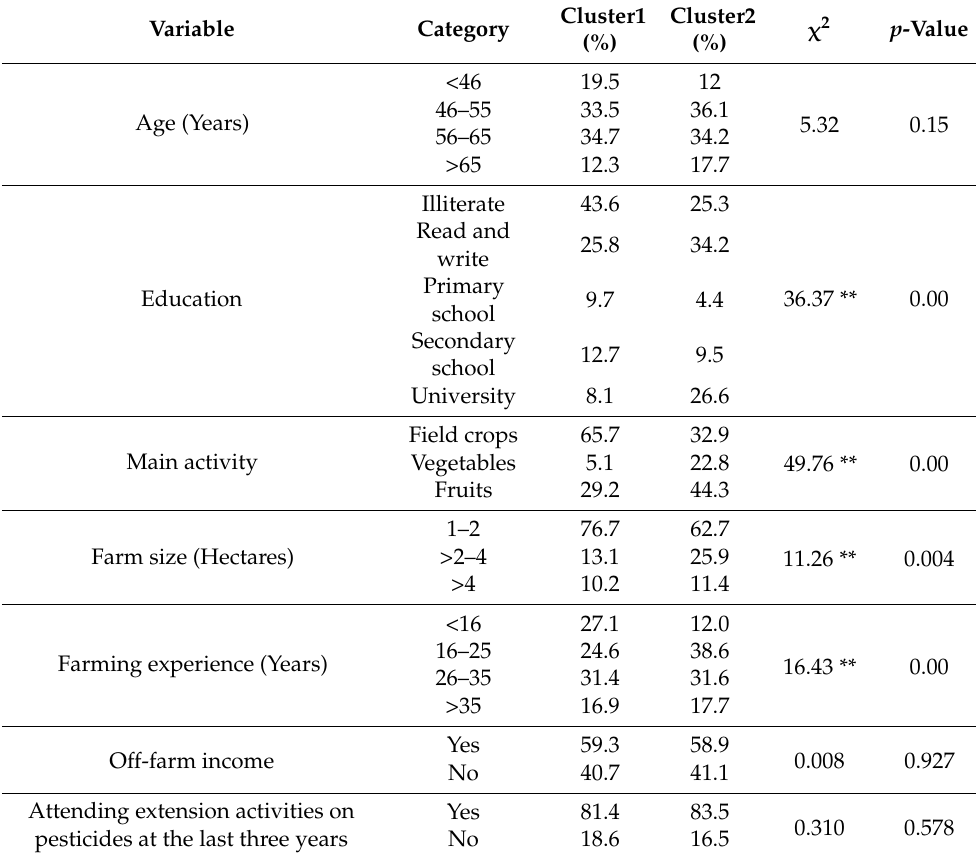
Table 7. Differences between farmer segments according to their demographic